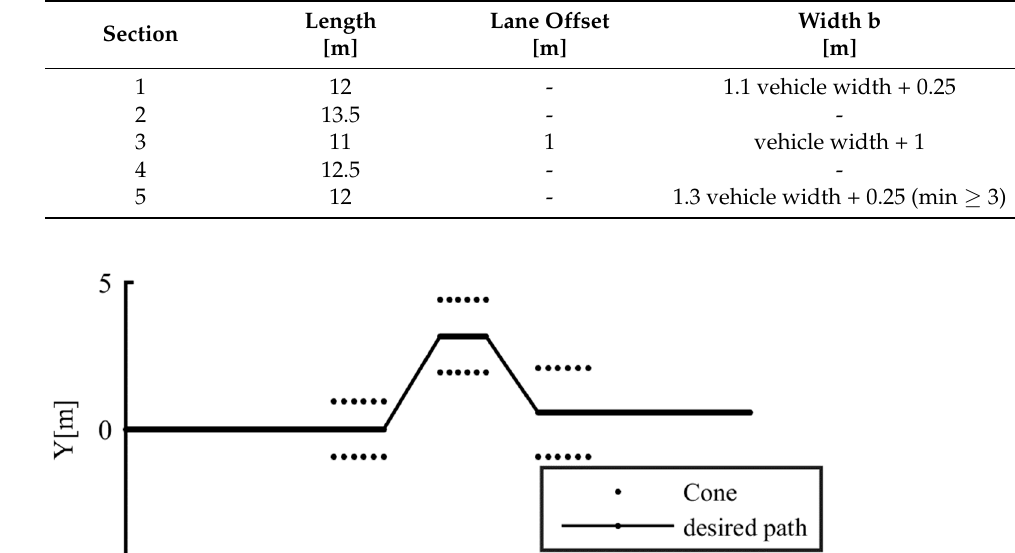
Table 2. Obstacle avoidance track dimension.